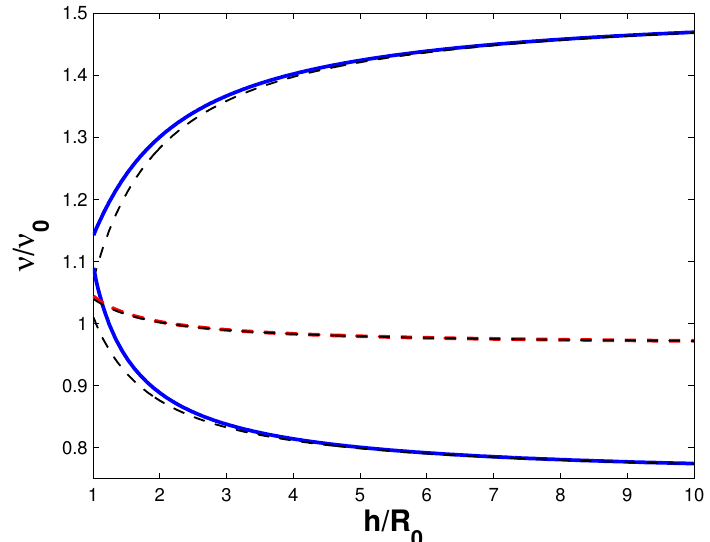
Figure 7. Normalized radiation damping factor as function of distance to boundary. Upper solid curve, lower solid curve and thick dashed line correspond to bubble above sediment layer, to bubble in sediments, to bubble in blood near arterial, respectively. Thin dashed lines correspond to case where only monopole component of interaction between bubble and its mirror image is taken into